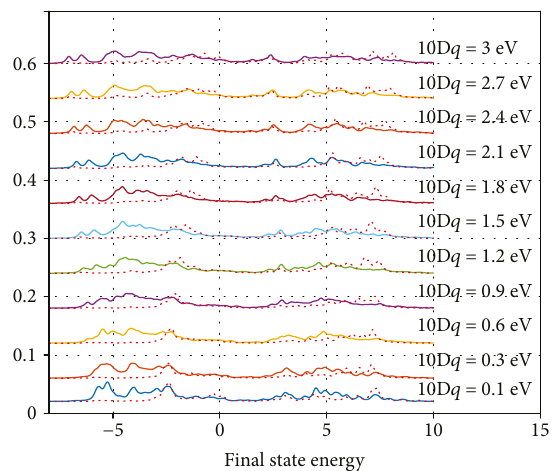
Figure 27: E ff ect of the O crystal fi eld on the 2p XES projections of h the calculated 1s2p RIXS spectra for Cr 4+ ( 3d 2 ).